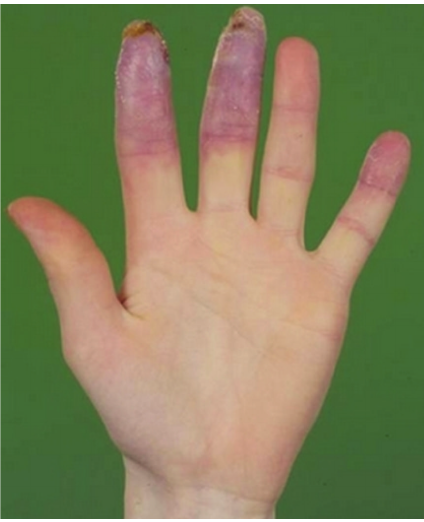
Figure 3: Ischemically threatened